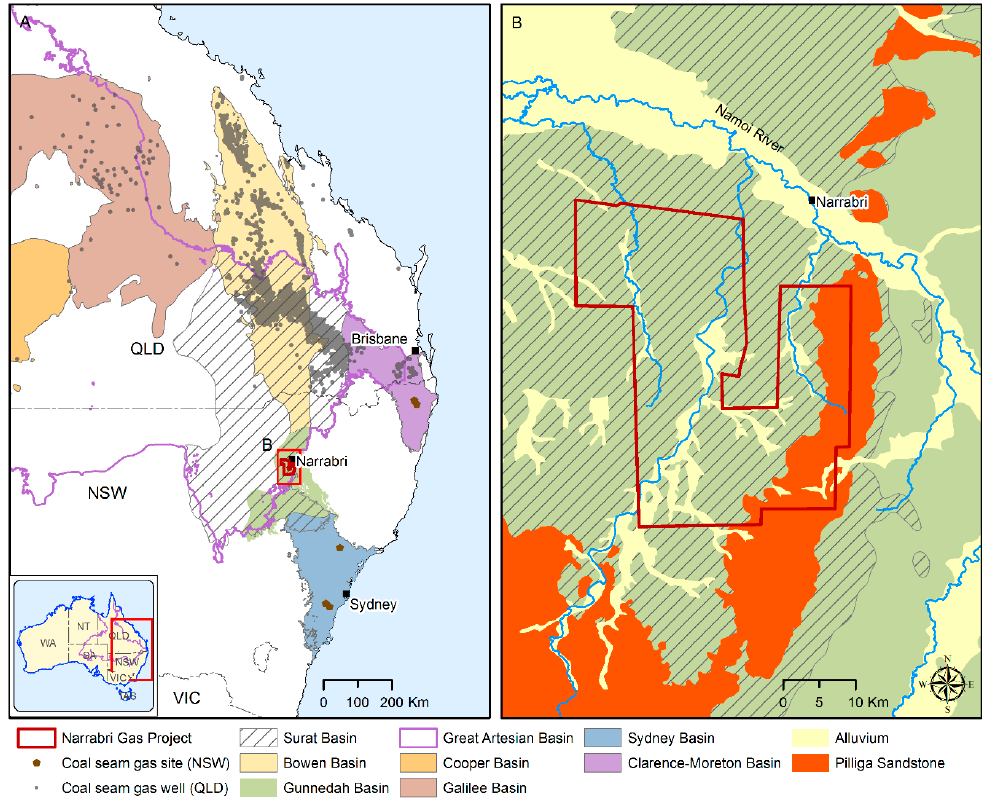
Figure 1. Geological basins and existing coal seam gas developments in Queensland and New South Wales ( A ), and outcropping extents of alluvial and Pilliga Sandstone aquifers in Australia near the Narrabri Gas Project area ( B ). Data sourced from [18].